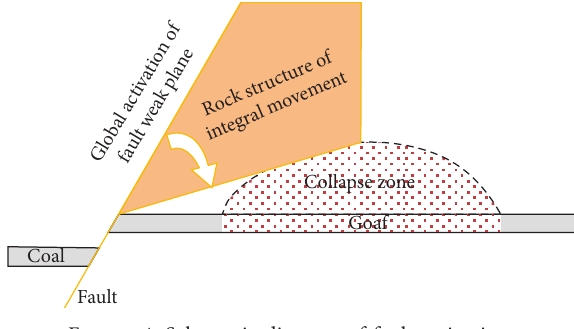
Figure 4: Schematic diagram of fault activation.